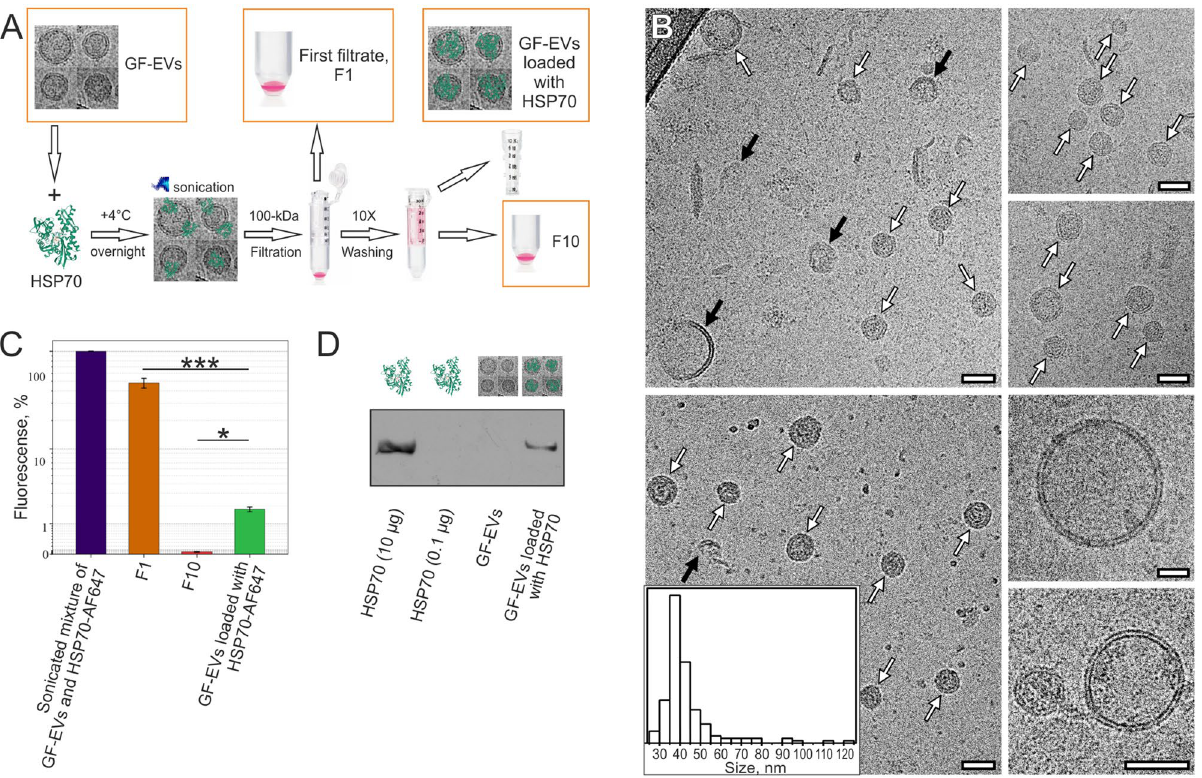
Figure 4. Loading efficiency of GF-EVs with HSP70 protein. ( A ) Flowchart summarizing the procedure of GF-EV loading with HSP70. ( B ) Cryo-EM images of GF-EVs loaded with HSP70. White arrows indicate vesicles with intact membrane, black arrows indicate vesicles with broken membrane. Scale bars are 50 nm. Inset—size distribution histogram. A total of 157 particles was analyzed. ( C ) Fluorescence of Alexa Flour 647 labeled HSP70 in the initial mixture and loaded samples of GF-EVs, as well as washing filtrates F1 and F10. N = 3. Data are presented as means ± standard deviation (SD). *, p < 0.05; ***, p < 0.001 as estimated by one-way ANOVA followed by multiple comparisons Tukey’s post-hoc analysis. ( D ) Western blot of HSP70 in the initial and loaded samples of GF-EVs. The full-length blot image used to generate panel is shown in Supplementary Fig.